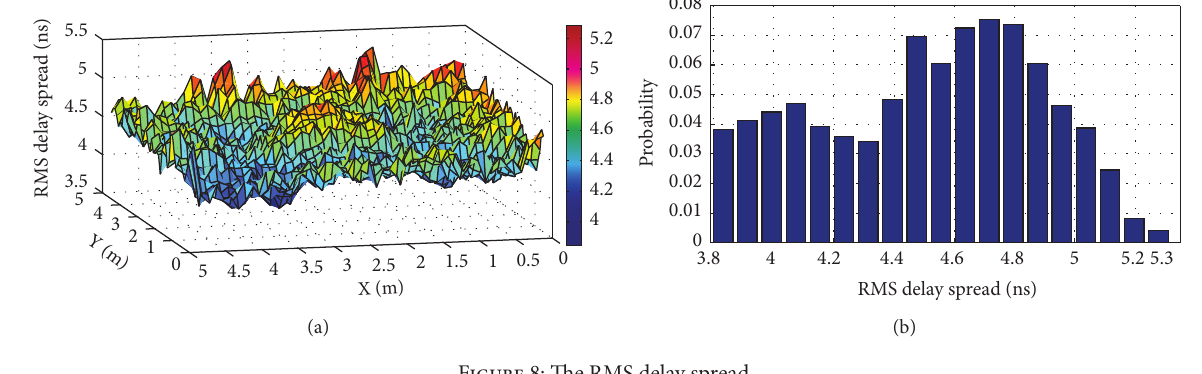
Figure 8: The RMS delay